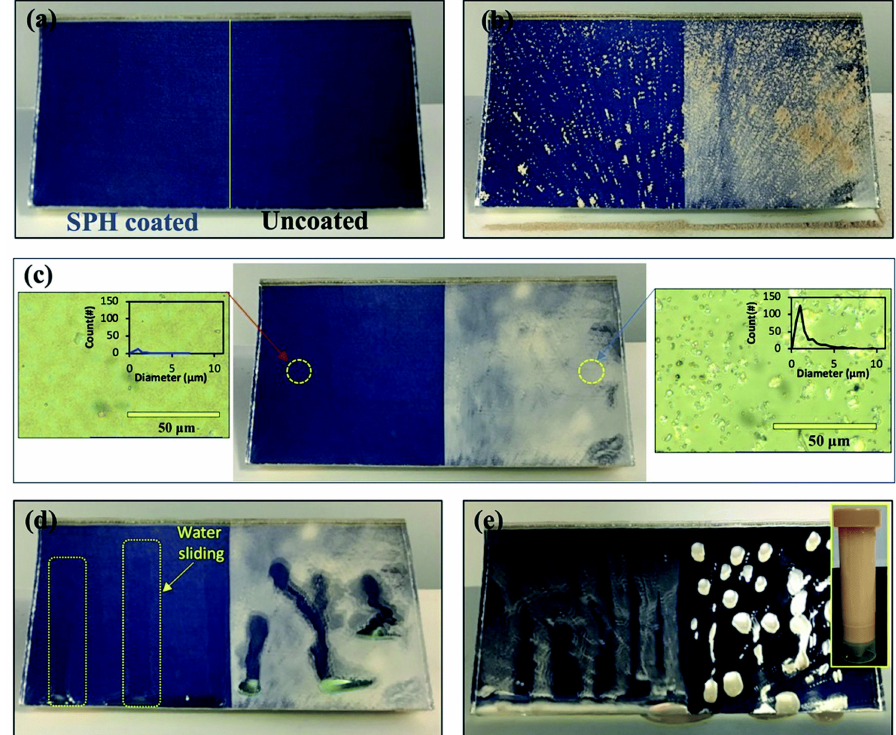
Figure 14. Observation of soiling on a mirror (15.2 × 7.6 cm 2 ) with half its area coated with nanopar- ticles to give it SPH properties. ( a ) A half-coated mirror at 45 ◦ elevation, ( b ) initial soiling (1 g) on the mirror, ( c ) dust accumulation on the mirror surface after airbrushing. Insets are optical micro- scope (5000 × magnification) images of soiling on an SPH-coated mirror and an uncoated mirror after airbrushing. ( d ) Water dripping on the mirror surfaces. The water was colored with a green dye. ( e ) Water disperses soil after dripping on the mirror surfaces. Inset is the suspended soil that was collected from the suspension in 0.1 g mL − 1 of soil and water mixture (ISO 12103-1 A4 Coarse Sand)